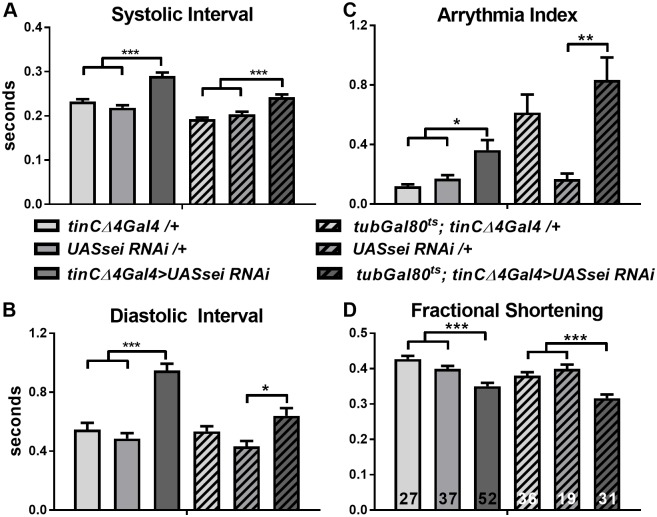
Heart and adult-specific knockdown of sei affects heart rhythmicity and contractility.Heart-specific KD of sei was achieved by crossing flies with a UASsei RNAi construct to the heart-specific driver tinCΔ4 Gal4. Adult specific KD was achieved using a temperature-sensitive driver tub-gal80ts in combination with tinCΔ4 Gal4 to knock down sei specifically in the adult heart (see Materials and methods). (A&B) Heart-specific (tin and adult specific KD of sei causes a significant increases in both systolic (A) and Diastolic Intervals (B) compared to controls (tinCΔ4 driver/+, tub gal80ts; tinCΔ4 driver/+, and UASsei RNAi /+) at 3 weeks of age. (C) Heart-specific and adult specific KD of sei causes a significant increases in arrhythmia compared to controls (tinCΔ4 driver/+, tub gal80ts; tinCΔ4 driver/+, and UASsei RNAi /+) at 3 weeks. (D) The fractional shortening, an indicator of heart contractility, was significantly reduced in 3 week sei KD hearts compared to controls. Significance was calculated using a two-way ANOVA and Tukey’s post-hoc test; *p<0.05, **P<0.01,****p<0.0001; number of flies examined is shown in bars in D.